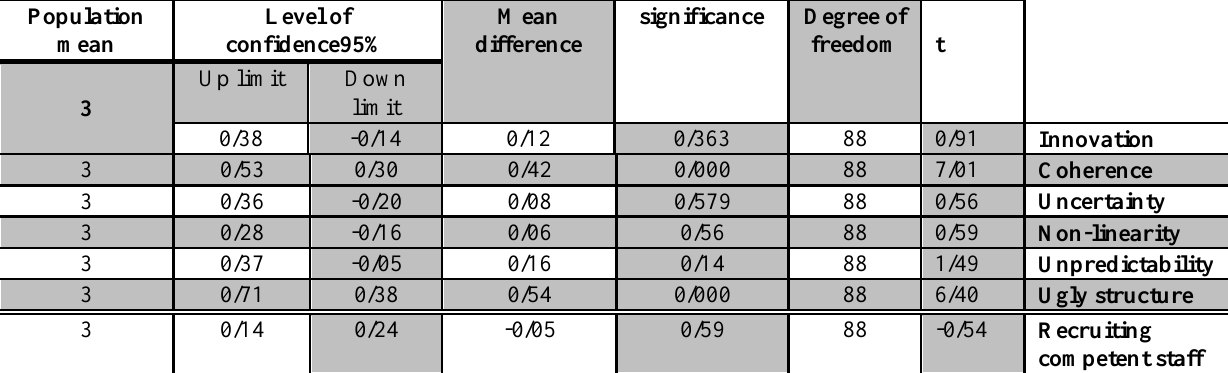
The results of one-sample t test of hypothesises in sport organizations